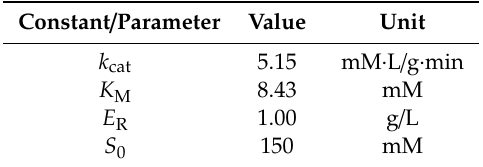
Table 1. Kinetic constants and parameters for the hydrolysis of lactose catalyzed by β -galactosidase at 35 ◦ C.